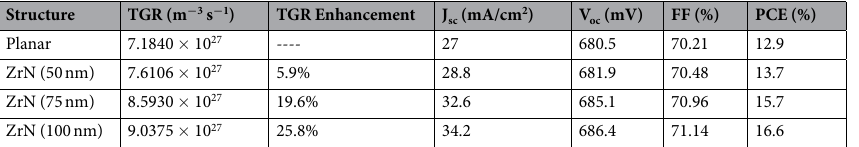
Table 2. The optical and electrical parameters of the ZrN-decorated